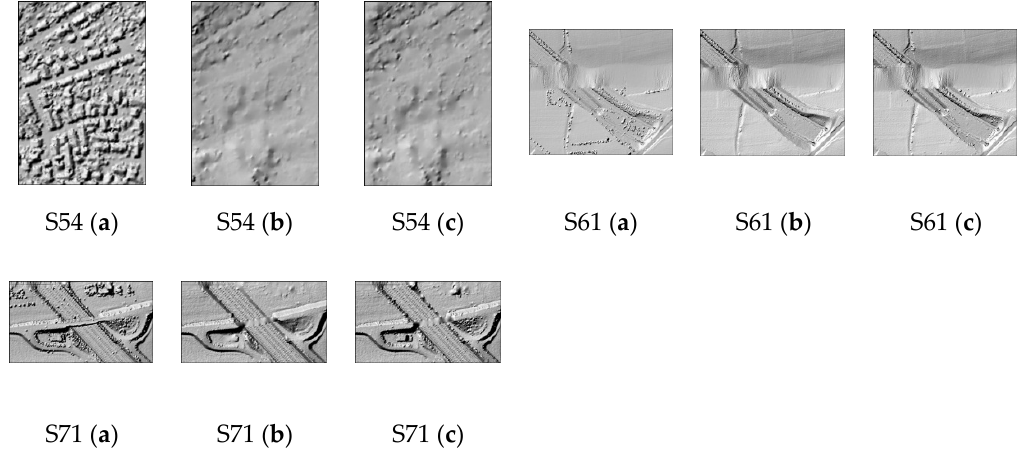
Figure 4. Filtering results: ( a ) the DSMs before filtering; ( b ) the true DEMs generated from the true ground points; and ( c ) the filtered DEMs generated from the ground points derived by the proposed filtering algorithm.